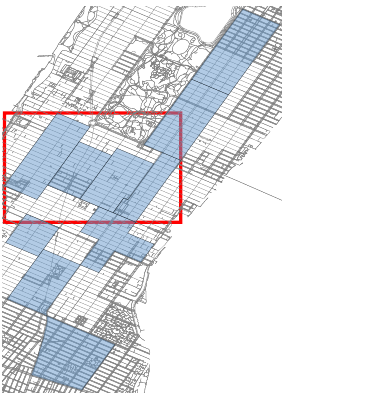
Figure 4. Left : The considered ten taxi zones of Manhattan with the highest number of pickups and drop-offs. Right : Exemplary distribution of SPR locations (black triangles) and potential service point locations (white